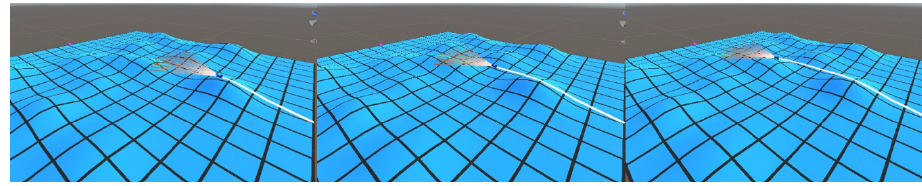
Figure 20. Failed trajectory for scenario